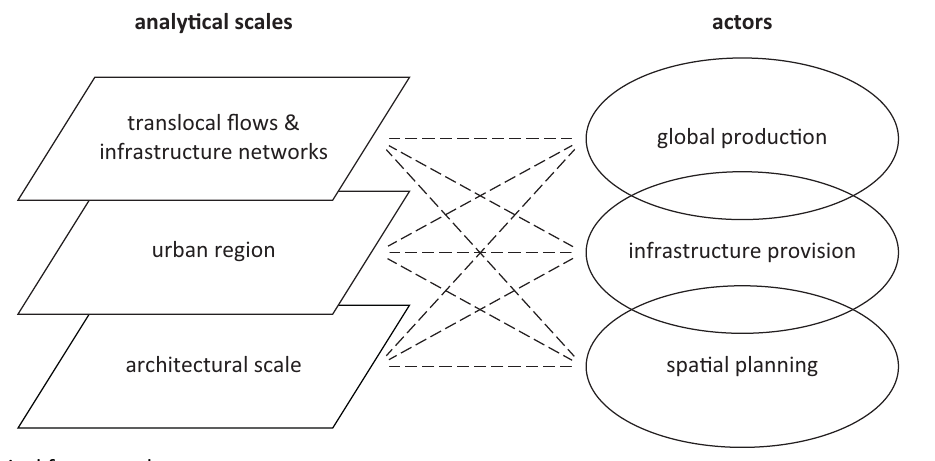
Figure 1. Analytical